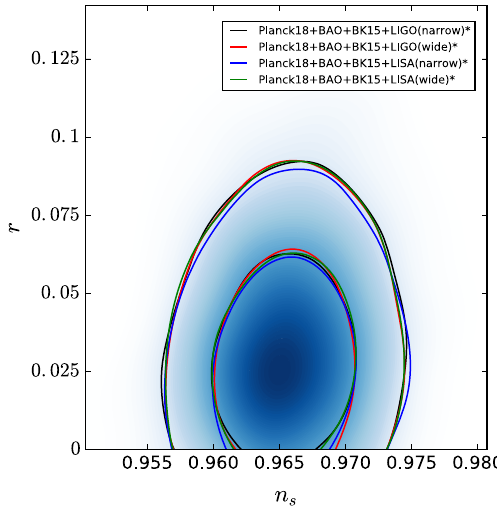
Fig. 7 Thecontourplotforthetensor-to-scalarratio r andparameter n s in the (cid:2) CDM+ r model at the 68% and 95% CL from the combinations of Planck18+BAO+BK15+LIGO n ∗ , Planck18+BAO+BK15+LIGO w ∗ , Planck18+BAO+BK15+LISA n ∗ , Planck18+BAO+BK15+LISA w ∗